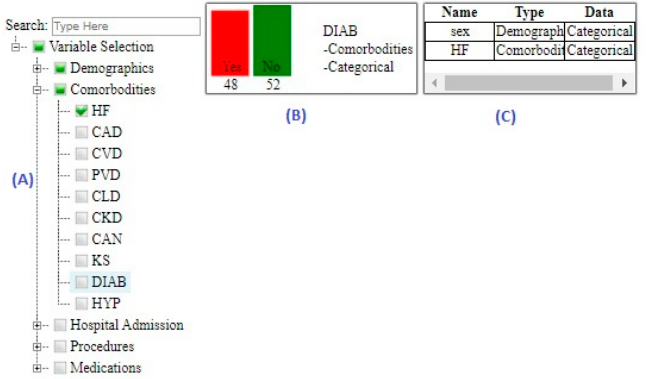
Figure 4. The raw-data subview containing ( A ) collapsible tree structure, ( B ) bar chart, and ( C ) data table.